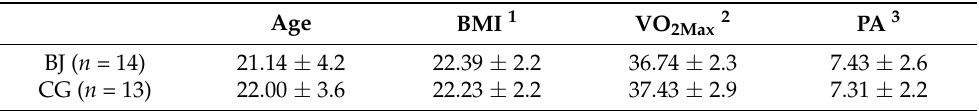
Table 1. General data of the